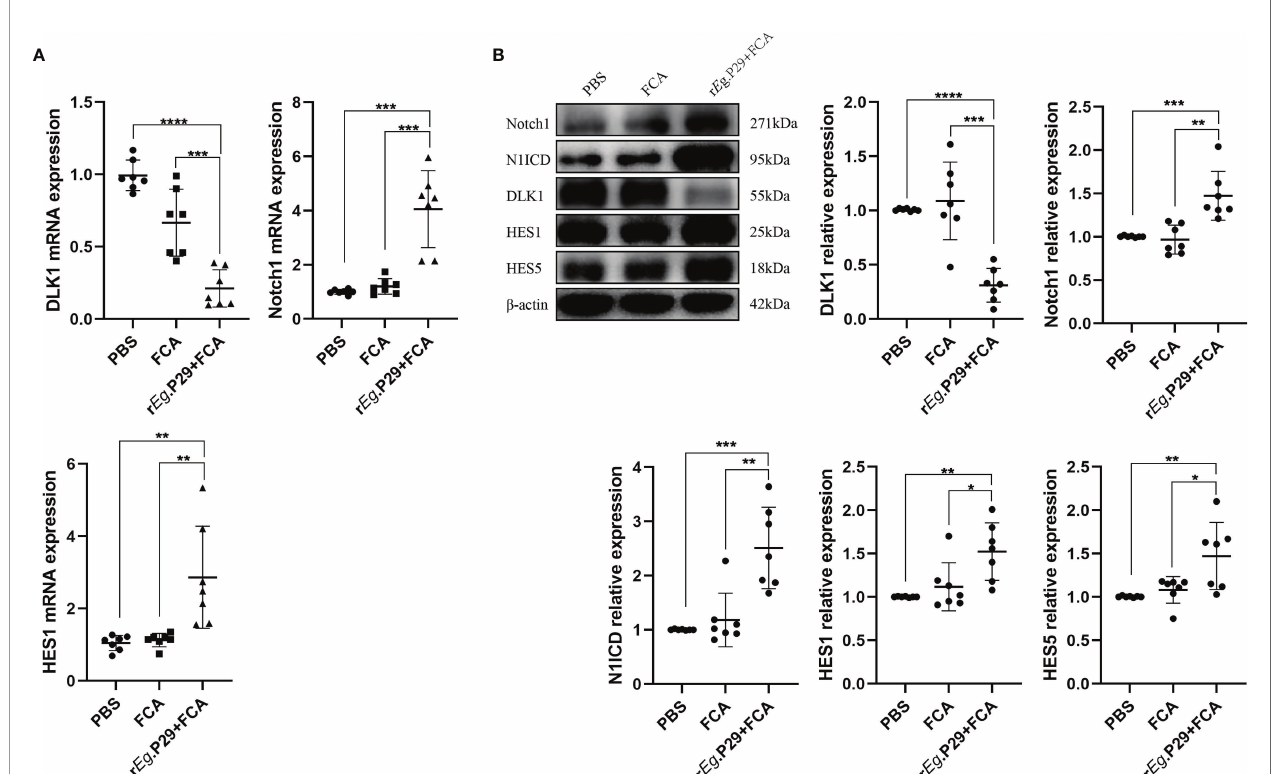
FIGURE 6 | Reduced DLK1 expression and enhanced Notch1 signaling pathway in spleen CD4 + T cells from r E g.P29-immunized mice. (A) Identi fi cation of DLK1, Notch1, and HES1 mRNA expression in naive CD4 + T cells after r E g.P29 immunization in mice 1 week after qRT-PCR. (B) Western blot detection of DLK1, Notch1, N1ICD, HES1, and HES5 protein expression in CD4 + T cells 1 week after r E g.P29 immunization in mice. * P < 0.05, ** P < 0.01, *** P < 0.001, **** P <